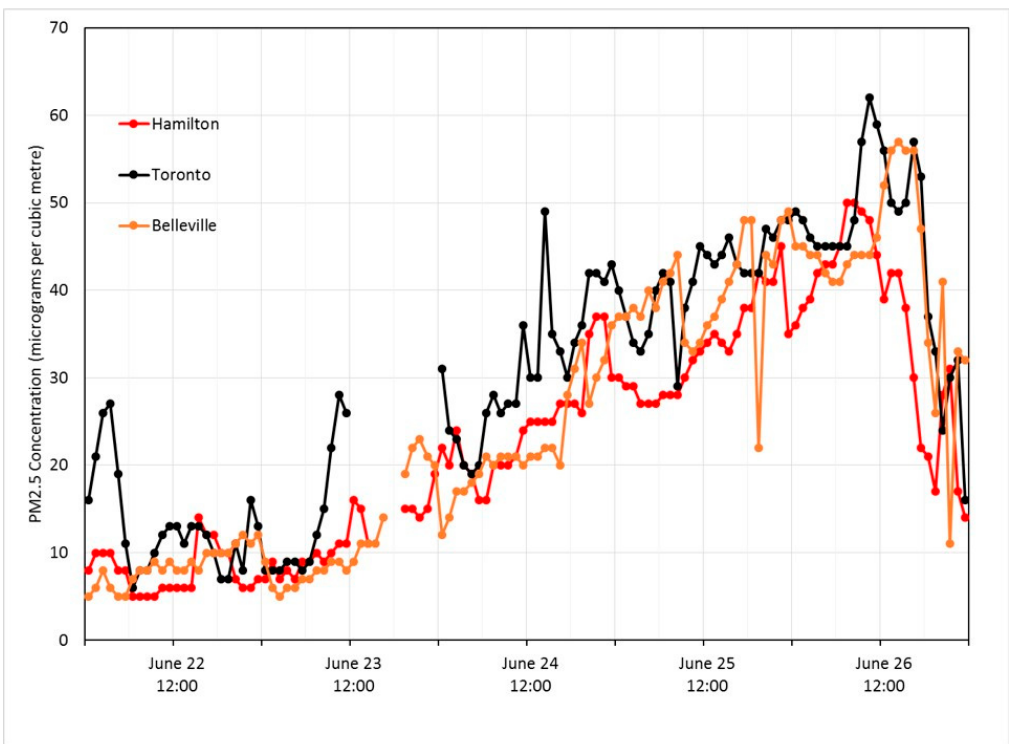
Figure 4. PM2.5 hourly concentrations at Windsor and Toronto during 22–26 June 2003. Dates are shown at EDT (local time) 12:00.